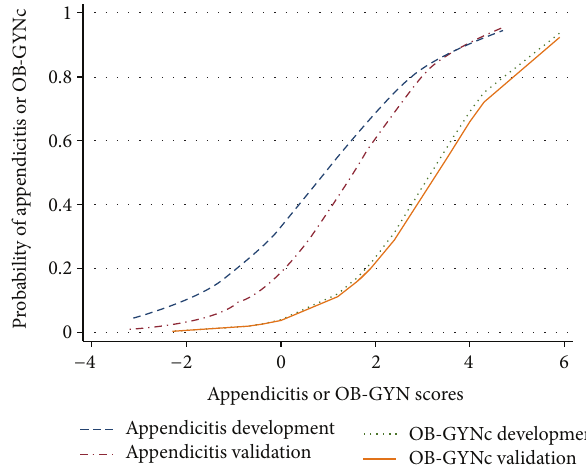
Figure 1: Estimated probabilities of appendicitis (dash and dash- dotted lines) and OB-GYNc (dot and solid lines) from actual rates of final diagnoses in development data set and validation data